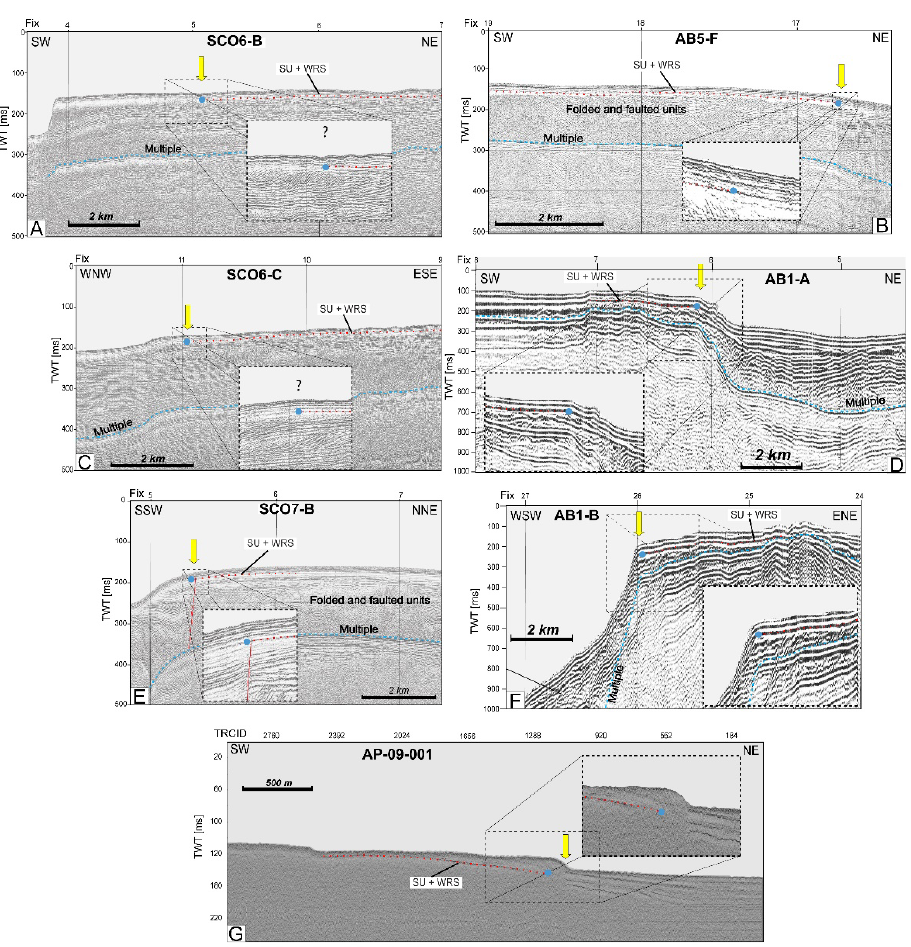
Figure 3. High-resolution seismic profiles acquired along the margins of the Adventure Plateau (see Figure 1 for location). See text for the description of the individual profiles ( A – G ). Yellow arrows indicate the mapped geographic locations (corresponding to the yellow dots in Figure 1) of the coastline at LGM, where the subaqueous clinoform rollover points have been identified (blue dots).